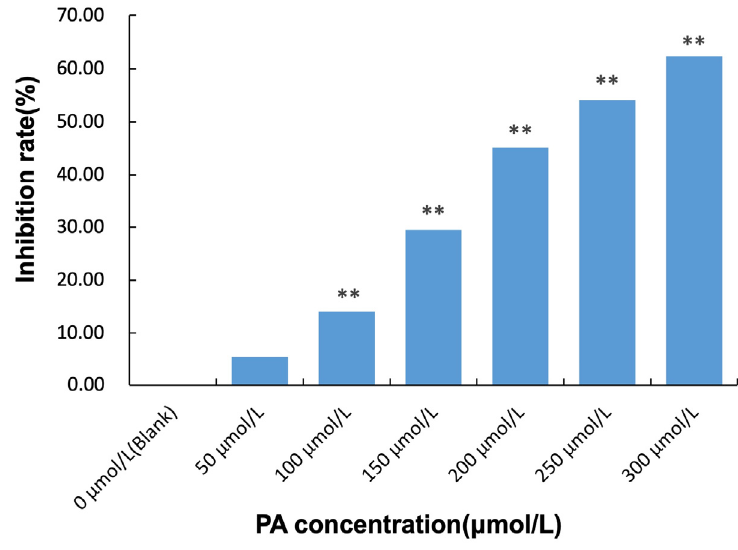
Figure 3. The inhibition rate of PA extracted from HUVEC. **: Compared with blank group, p < 0.01. Table 4. The inhibition rates of 16 batches of WDD (Mean ± SD, n = 3,).